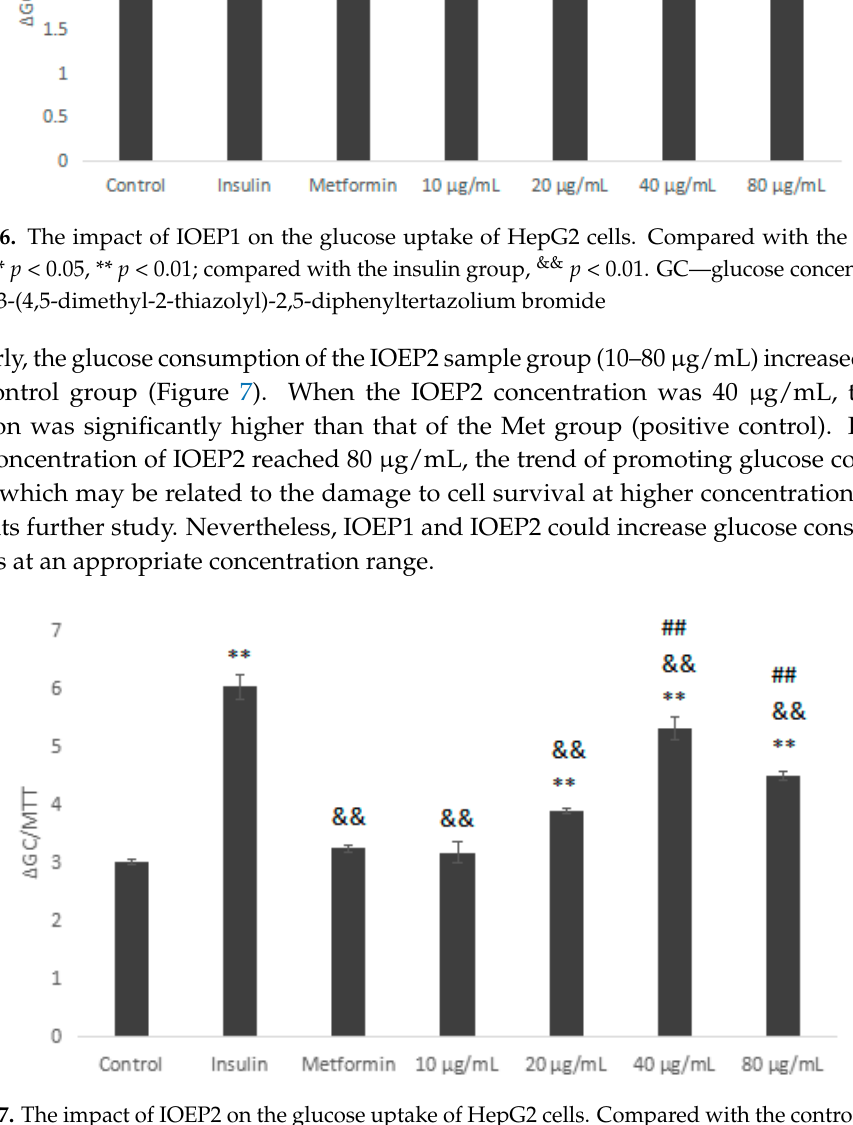
Figure 7. The impact of IOEP2 on the glucose uptake of HepG2 cells. Compared with the control group, ** p < 0.01; compared with the insulin group, && p < 0.01; compared with the Metformin (Met) group, ## p < 0.01.